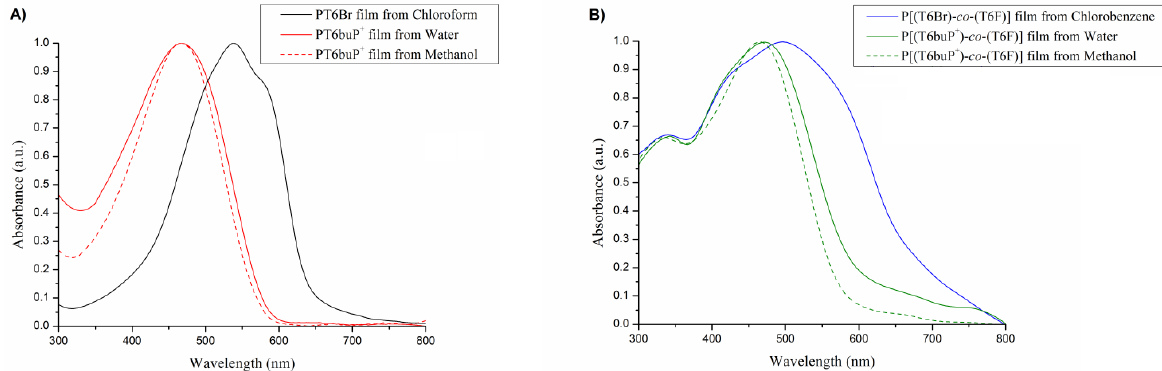
Figure 4. UV–Vis spectra of homo- ( A ) and double-cable copolymers ( B ) in thin film by drop-casting from different solvents. Table 2. Maximum absorption wavelengths of polymers in thin